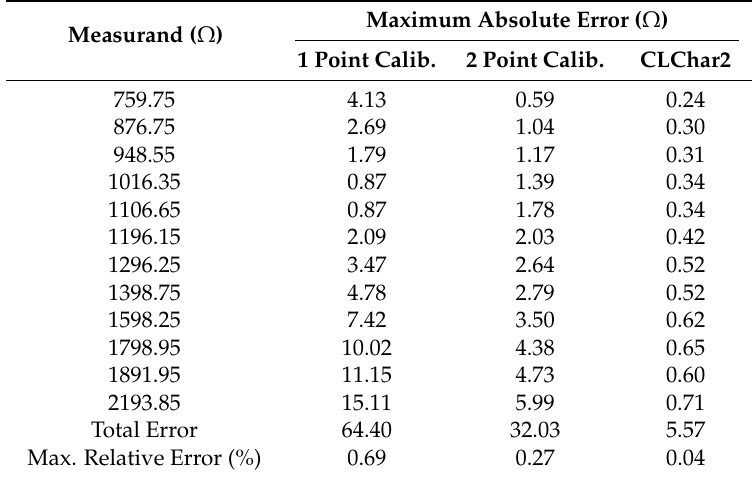
Table 4. Accuracy data for the PT-1000 temperature sensor and different calibration techniques.